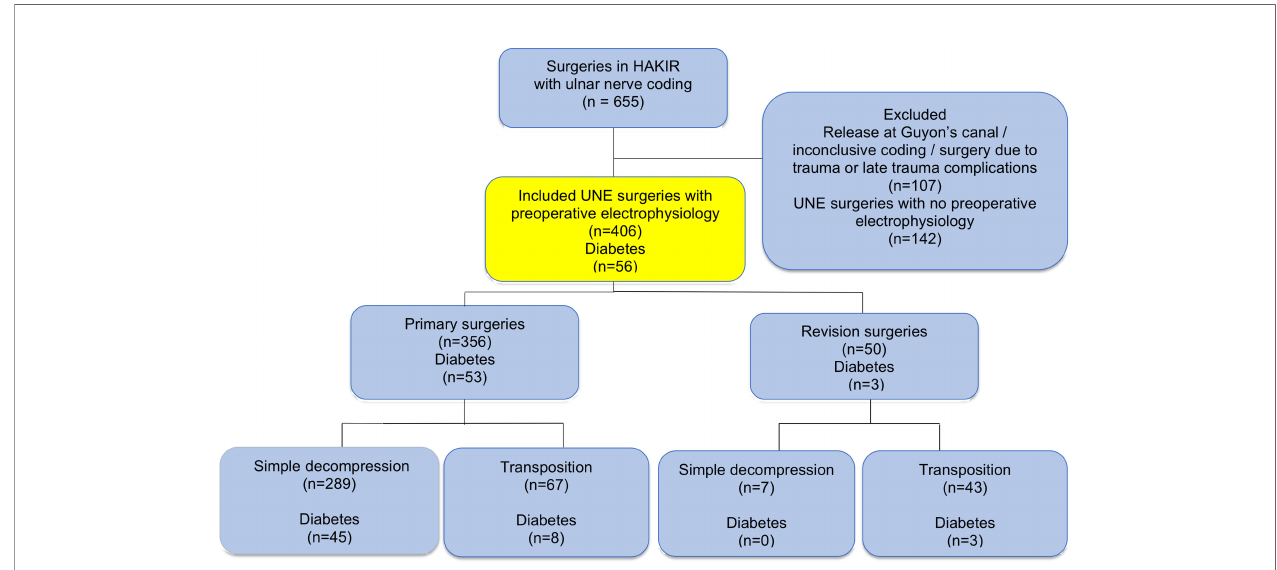
FIGURE 1 | Flow chart describing the inclusion process of surgeries due to ulnar nerve compression from national quality register HAKIR (top blue), where preoperative electrophysiology examination was available of cases with ulnar nerve compression at the elbow (UNE) (yellow). Included cases are indicated and also speci fi ed concerning the number of cases with diabetes. For details see